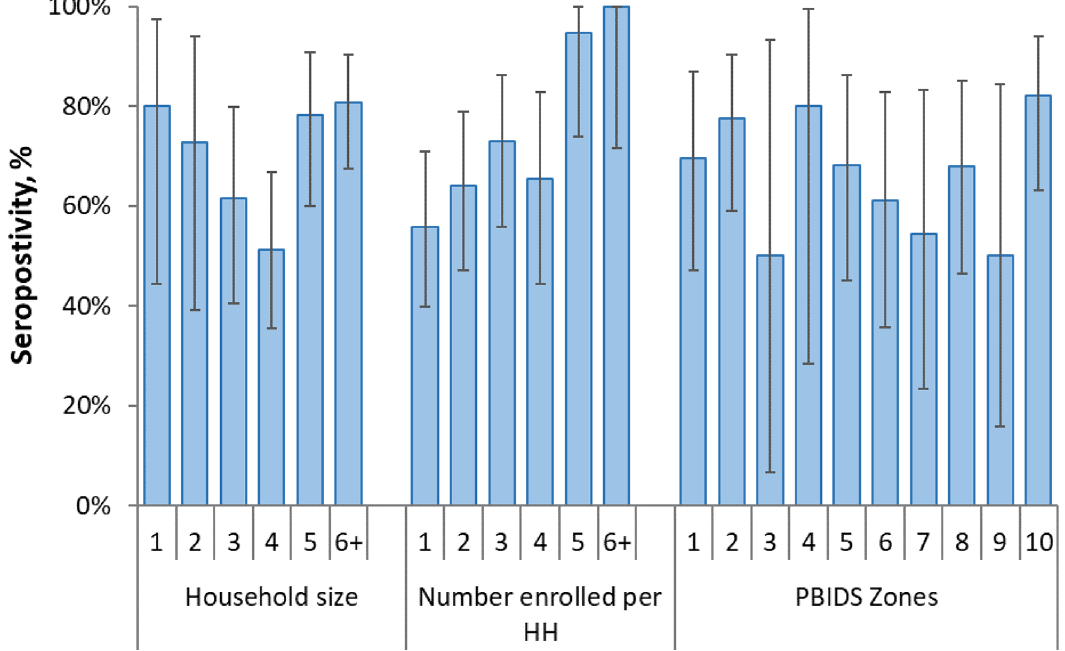
Figure 5. Household (HH) seropositivity (at least one person testing positive in the household) by household size, number of enrolled persons per household and location in the population-based infectious disease surveillance (PBIDS) area as of December 2020. PBIDS zones are areas of residence numbered 1-10.